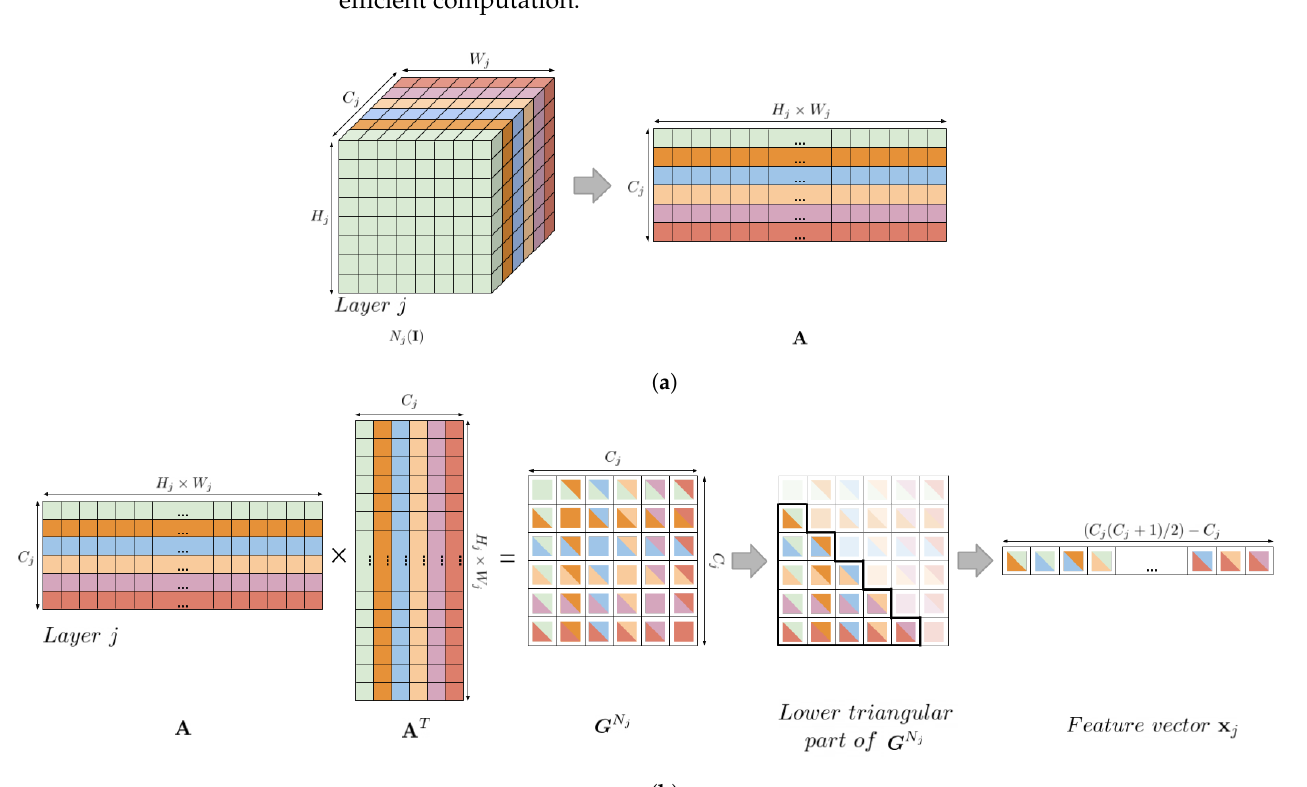
Figure 3. Visual overview of the Gram matrix efficient computation and feature vector extrapolation. In ( a ) is shown how the activation volume is reshaped to efficiently compute the Gram matrix in ( b ) to finally compute the feature vector that represents the intra-layer